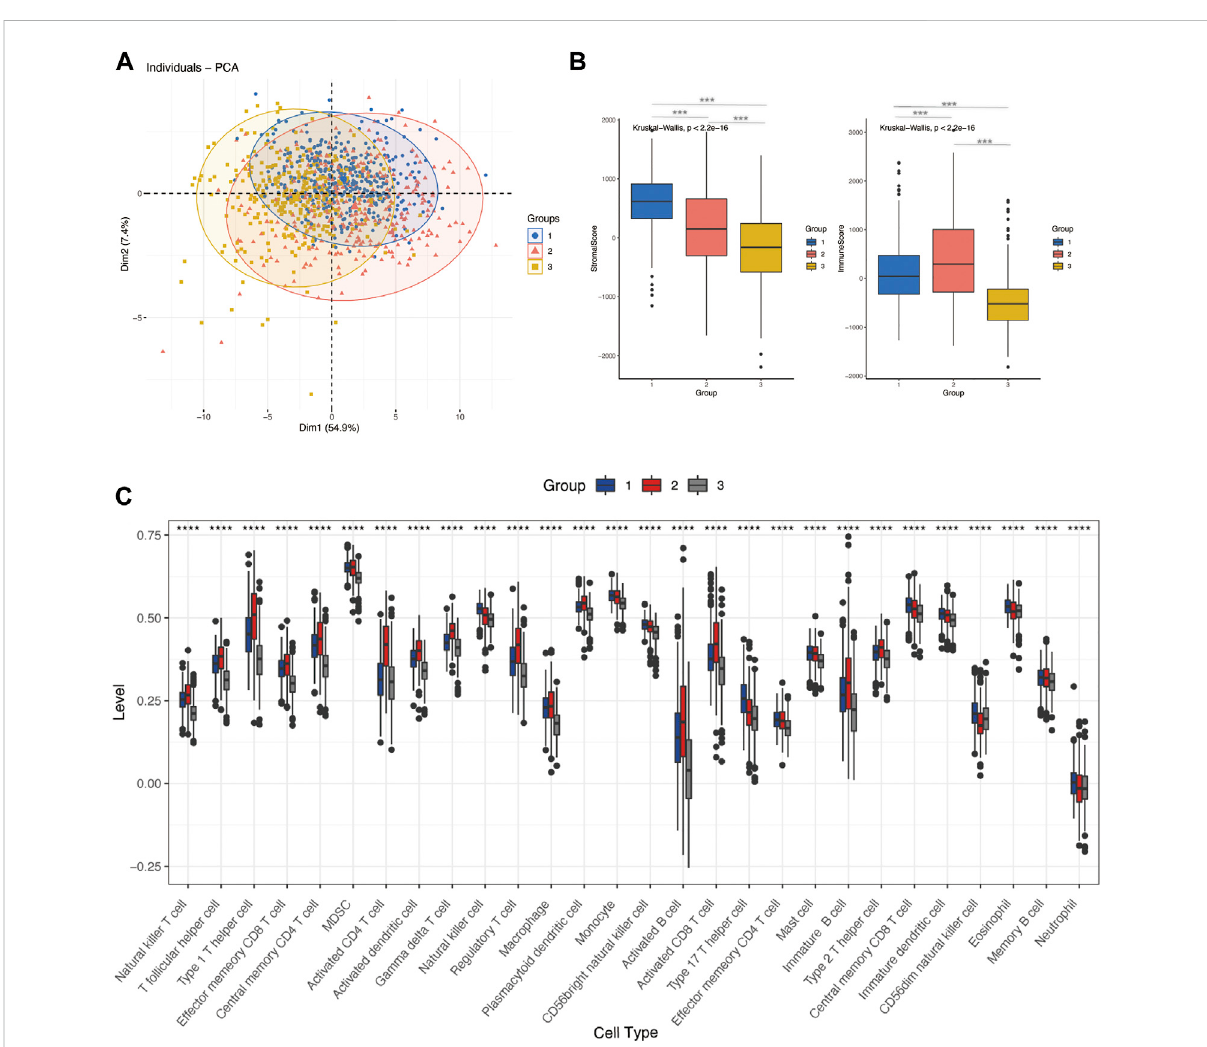
FIGURE 3 Differencesinimmunecharacteristicsofglycosylation-basedgroups. (A) PCAclusteringofsampledistributionsinimmunesignaturesbetween three glycosylation-based groups. (B) Stomal score and the immune score of glycosylation-based groups (ESTIMATE algorithm). (C) Differences in 24 TME in fi ltration cells between glycosylation-based groups (ssGSEA) (**** p <